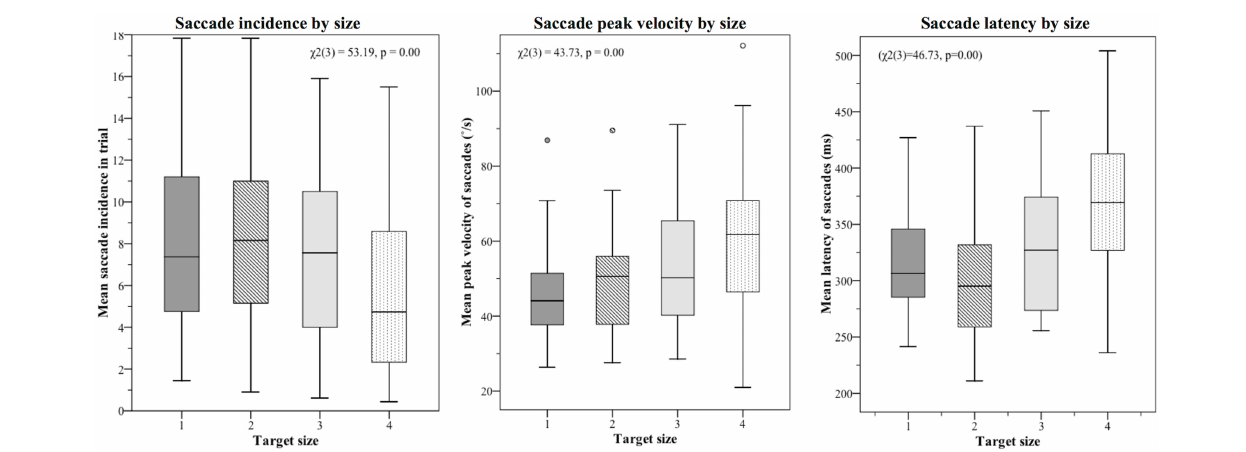
FIGURE 3 | Saccade metrics plotted by target size. The largest target size 4 was always tested first, and the effect of trial order was also statistically significant. When the first target was removed from analysis, order effects became non-significant, though a small but significant effect of target size remained (effect sizes: 0.08 (incidence), 0.12 (velocity), 0.13 (latency). The small effect of target size is best summarized as such: Smaller targets produce more saccades, which tend to be smaller and occur earlier; larger targets produce fewer saccades, but these have higher peak velocities and occur later in the recording